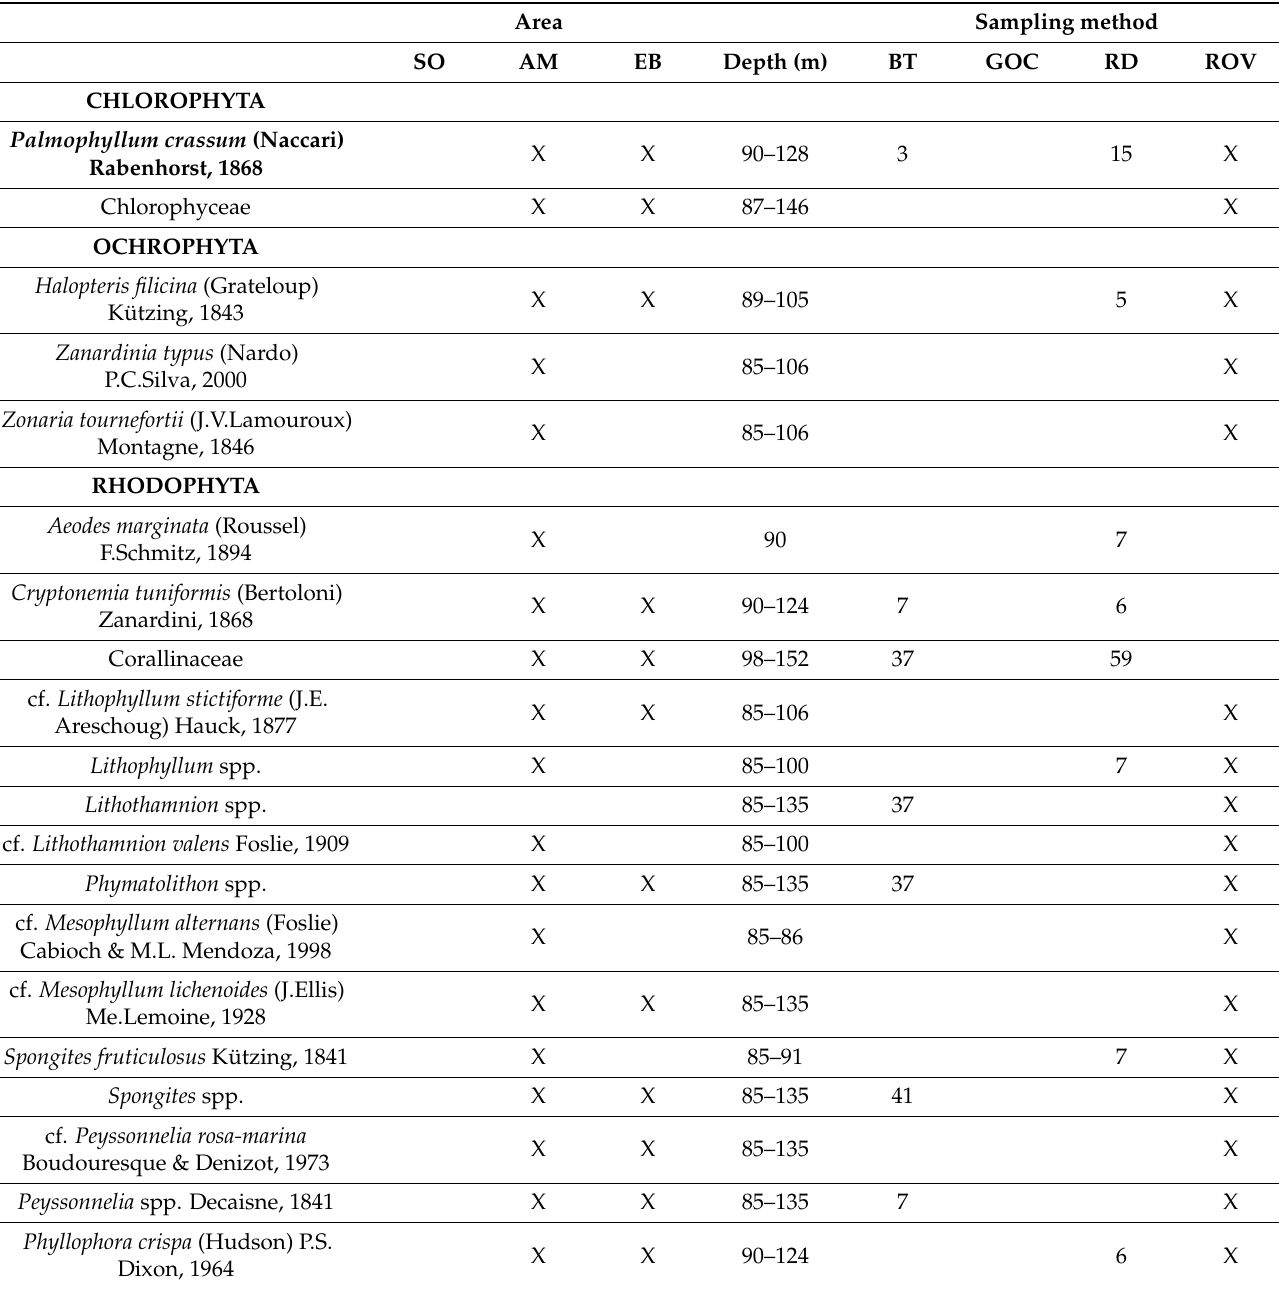
Table A7. Inventory of species or taxa identified so far from the sampling developed in the Ses Olives, Ausias March, and Emile Baudot seamounts and adjacent bottoms of the Mallorca Channel (Balearic Islands, western Mediterranean) during the INTEMARES project, with beam trawl (BT), the GOC-73 experimental bottom trawl (GOC), rock dredge (RD), and remote operated vehicle (ROV). The area and depth in which the species or taxa have been found as well as their frequency of occurrence are also shown. (*) Not been taken into account for biodiversity estimations, since they may be species or taxa repetitions.